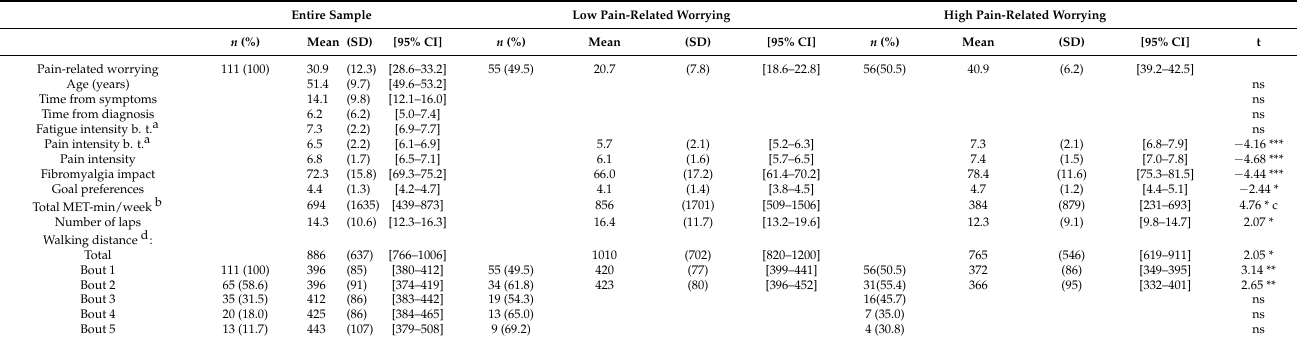
Table 1. Descriptive and difference